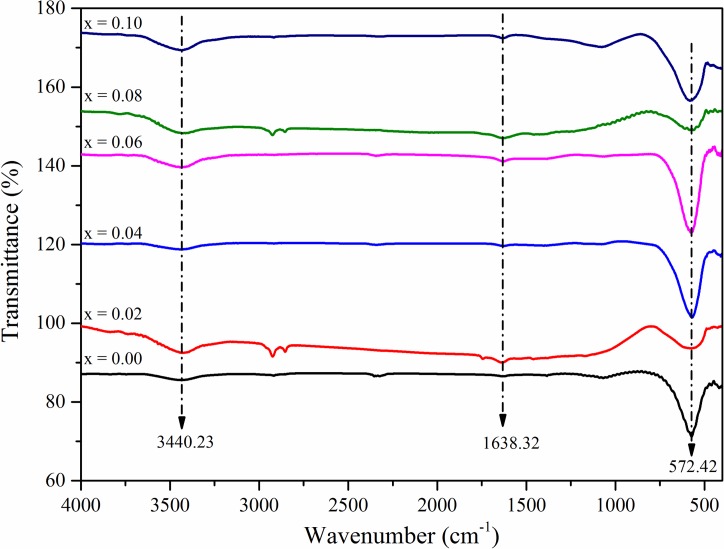
FTIR spectroscopic analysis to identify the types of chemical bonding in La3+ substituted Ni-Zn ferrite nanoparticle.FTIR spectra for the samples of Ni0.5Zn0.5LaxFe1-xO4 nanocrystalline at various La3+ substitution concentrations.